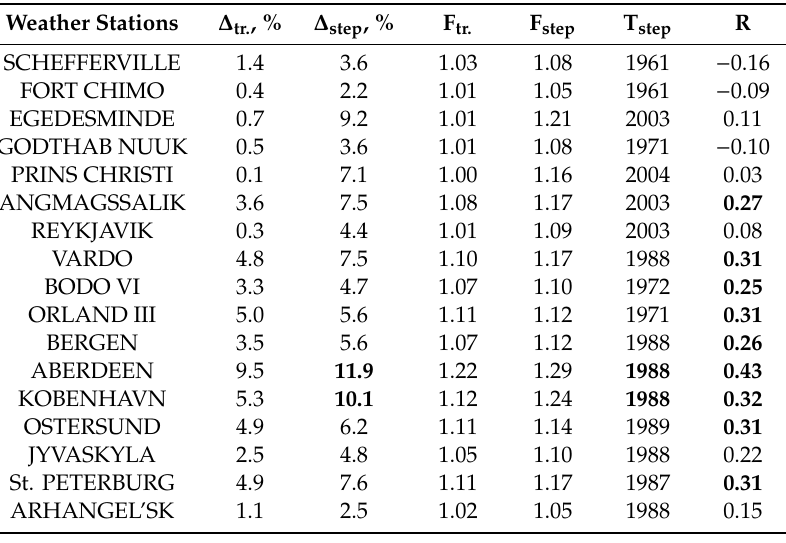
Table 4. The results of the e ffi ciency assessment of non-stationary models for the SAT time series at every weather station in February (1951–2016 period, with the size of the time series n = 66). The bold font for ∆ step is used when the values are higher than or equal to 10%. The bold font for T step is used for the cases when ∆ step ≥ 10%. The bold font for R denotes statistically significant correlation coe ffi cients of linear trends for the whole